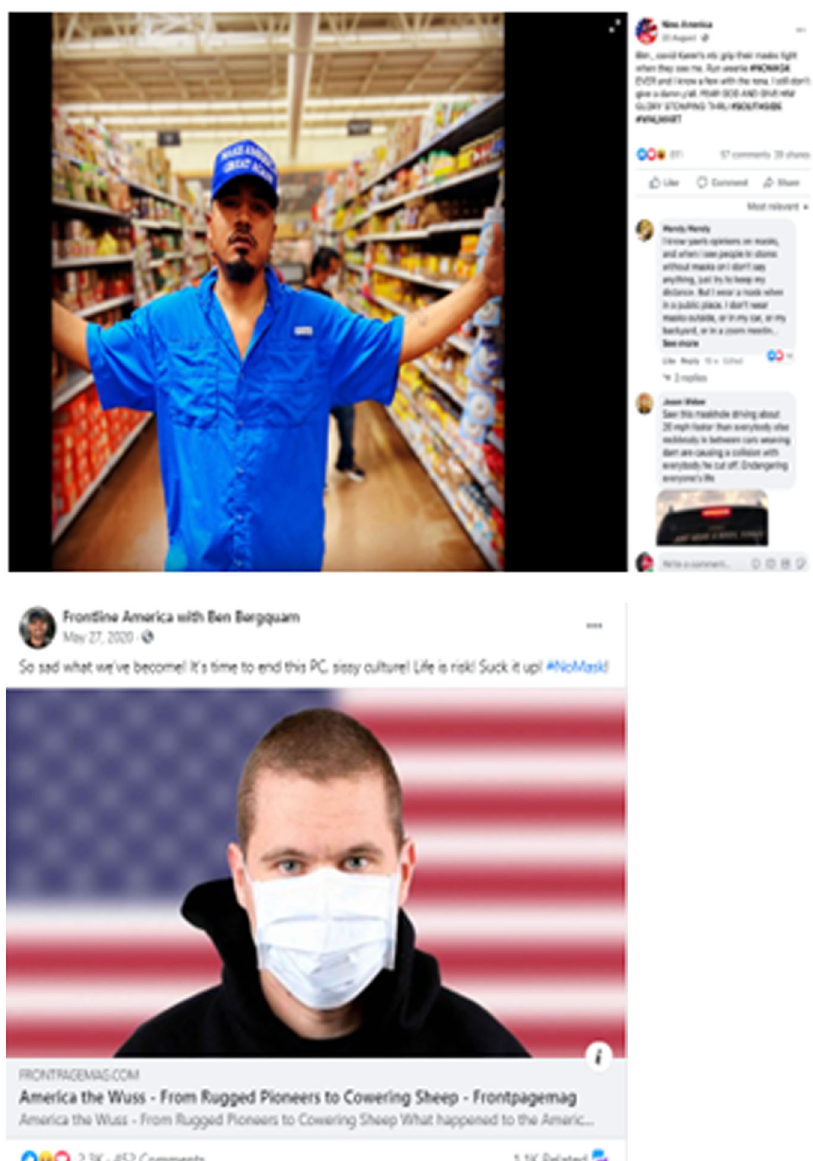
Fig. 2 Social media posts representing hypermasculine